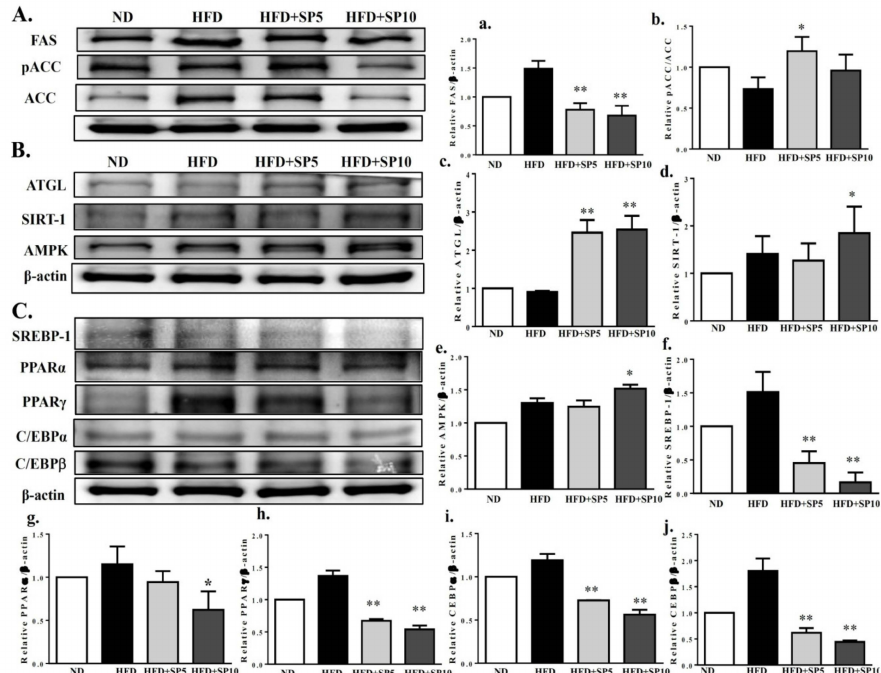
Figure 8. Treatment with spilanthol (SP) downregulates the lipogenesis and adipogenesis-related transcription factors, and upregulates lipolysis-related and AMPK pathway protein expression in the livers of HFD-fed mice. ( A ) Western blots of lipogenesis-related proteins FAS and pACC, ( B ) lipolysis protein triglyceride lipase (ATGL), sirtuin 1 (SIRT1), and AMPK, and ( C ) adipogenic transcription factors sterol regulatory element-binding protein (SREBP-1), peroxisome proliferator-activated receptor (PPAR) α , PPAR γ , CCAAT / enhancer-binding protein (C / EBP) α , and C / EBP β . β -Actin was used as an internal control. The relative protein levels of FAS (a), pACC (b), ATGL (c), SIRT1 (d), AMPK (e), SREBP-1 (f), PPAR α (g), PPAR γ (h), C / EBP α (i), and C / EBP β (j) in the liver are also given. Data are presented as means ± SD ( n = 8); * p < 0.05, ** p < 0.01 compared to HFD-induced obese